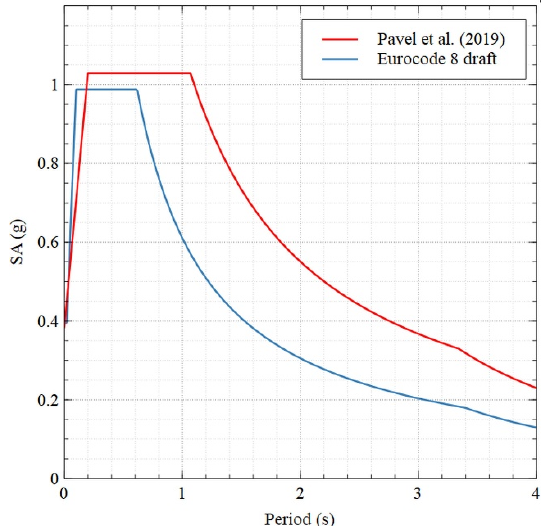
Figure 10. A comparison between the design acceleration response spectra for Bucharest computed using the site amplification proposed by Pavel et al. [4] and the site amplifications from the Eurocode 8 draft revision [1].